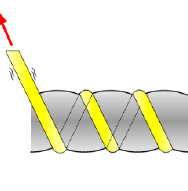
Figure 1. Modified braidtrusion process.